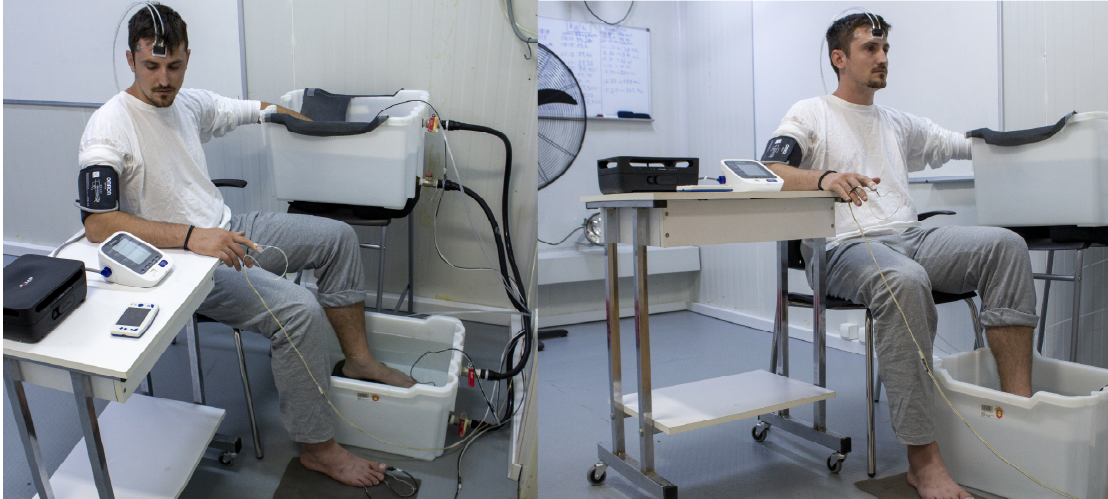
Figure 1. A male participant during the data collection. Note: the right sleeve of the shirt was cut at elbow height to avoid constricting blood flow. The blood pressure cuff was comfortably placed at the upper arm without constricting blood flow except when assessing arterial blood pressure. Pho- tograph used with permission from the participant featured.